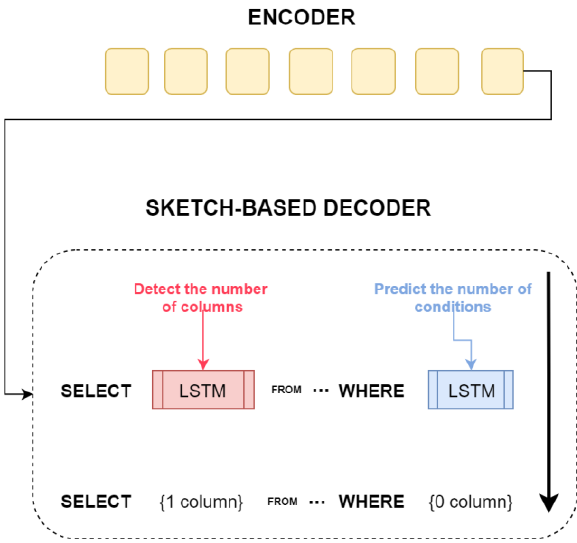
Figure.3. A Sketch-based decoder. The decoding is performed for each independent sub-module. Before the generation process, the number of elements in each slot should be inferred. The Figure.3 displays the overview of the process of getting the number of columns and the number of conditions in the where clause of a potential query. Each element is treated as a classification problem. For example the number of conditions in the where clause is an N-way classification one, with N as the maximum possible number of conditions in that slot.